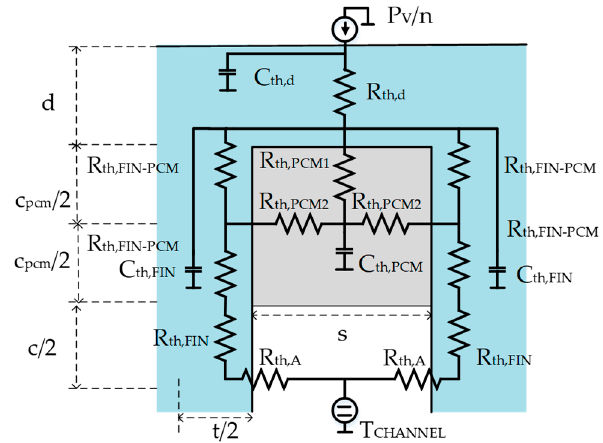
Figure 2. The thermal network showing the heat flow through one channel of the PCM heat sink.